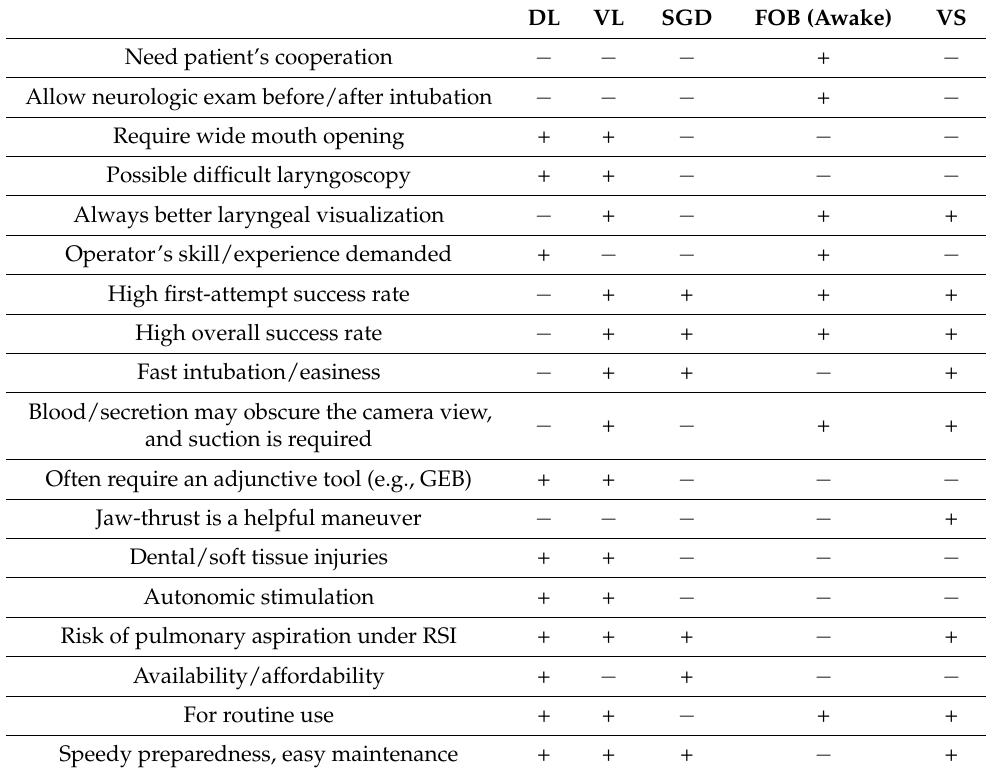
Table 2. Comparison of airway management modalities for patients with restricted cervical spine